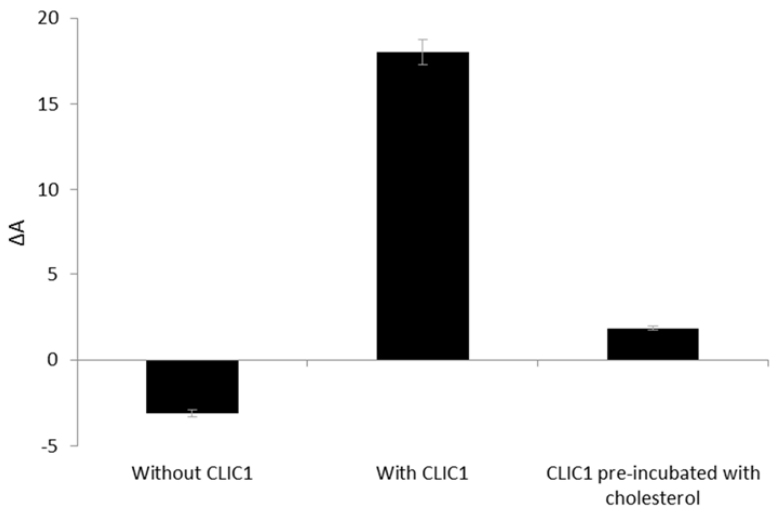
Figure 6. Percent area expansion profiles of POPC:Chol monolayer after 3 h without CLIC1 protein or after injection of recombinant CLIC1 wild-type and pre-incubated CLIC1 protein. CLIC1 was pre-incubated with cholesterol for an hour on ice prior to addition of the pre-incubated protein sample to the monolayer held at a constant surface pressure of 20 mN ¨ m ´ 1 . Pre-incubation of CLIC1 protein with cholesterol resulted in complete abrogation of CLIC1 insertion into the monolayer.